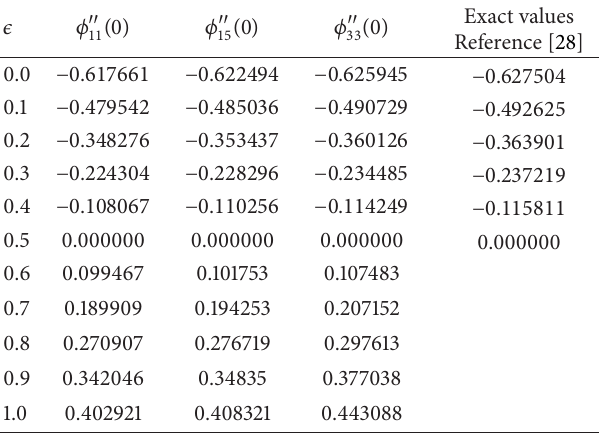
Table 2: The approximate values of the skin-friction coefficient 𝑓 󸀠󸀠 (0) for the class of the Falkner-Skan problem using 11, 15, and 33 terms of Adomian’s series.